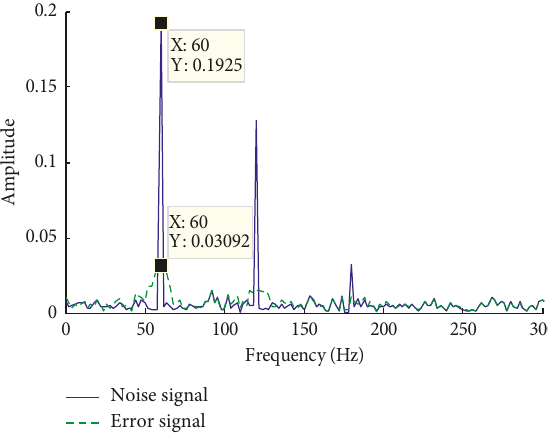
Figure 9: Amplitude-frequency curves of noise and error signals at 1800 Table 3: Noise reductions at different rotational speeds.